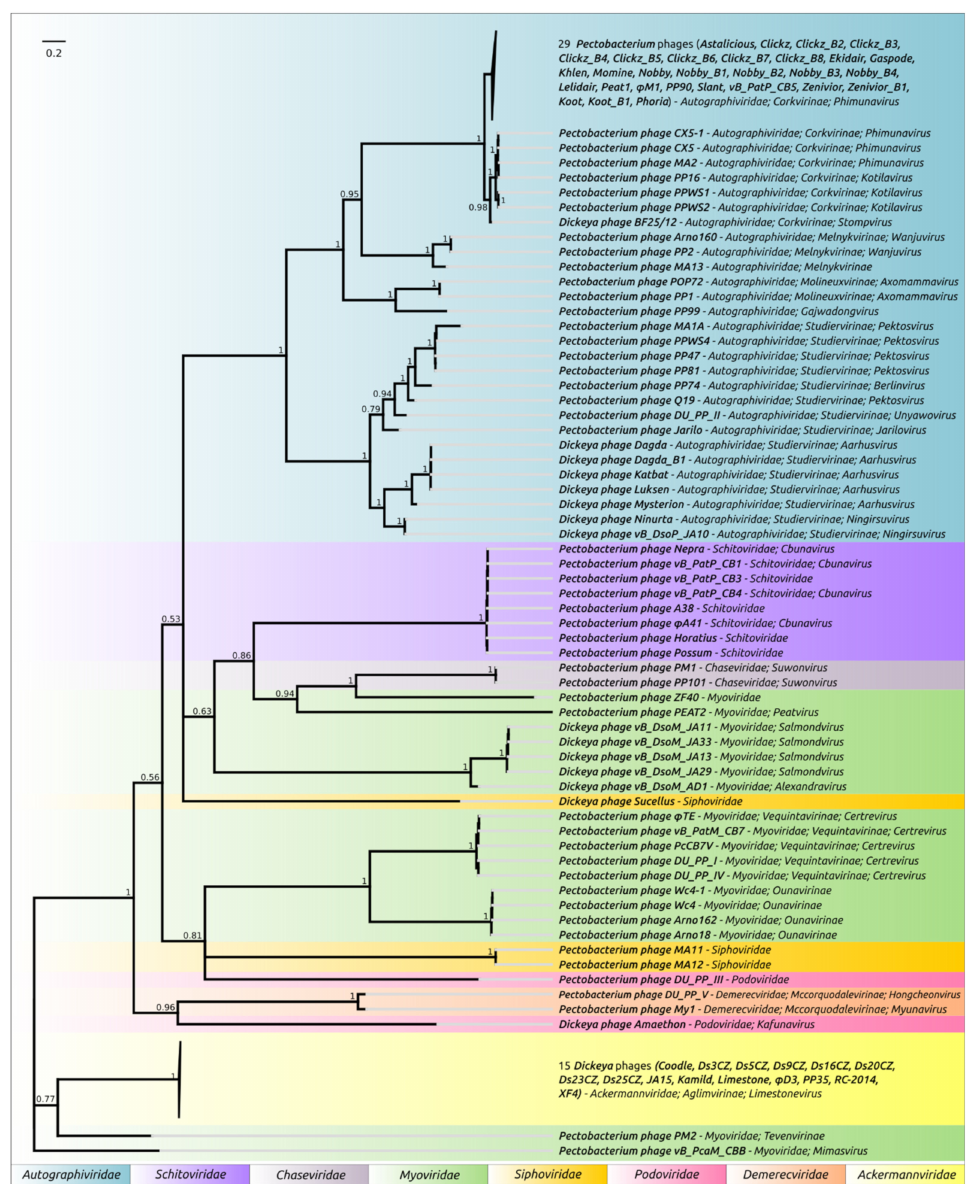
Figure 3. Phylogenetic tree obtained with MrBayes based on concatenated amino acid sequences of major capsid protein and terminase large subunit. Bayesian posterior probabilities are indicated near their branches. Taxonomic classification is shown to the right of the phage name. The scale bar shows 0.2 estimated substitutions per site and the tree was rooted to Pectobacterium phage vB_PcaM_CBB. The chain length was 3,300,000, the burn-in length was 300,000, the subsampling frequency was 200 and the average standard deviation of split frequencies was